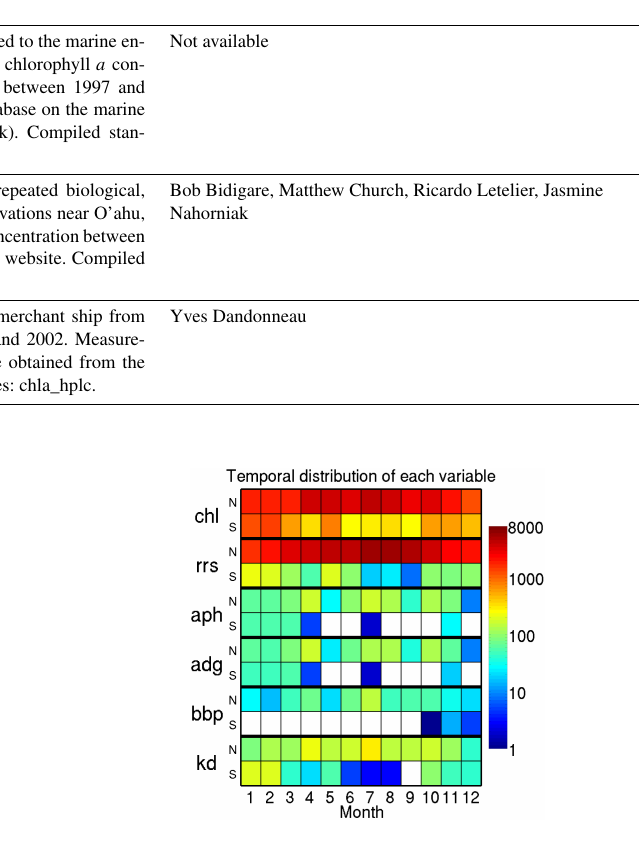
Figure 3. Temporal distribution of chlorophyll a concentration (chl), remote-sensing reflectance (rrs), algal pigment absorption co- efficient (aph), detrital plus CDOM absorption coefficient (adg), particle backscattering coefficient (bbp) and the diffuse attenua- tion coefficient for downward irradiance (kd) in the final table. All chlorophyll data were considered, but for a given station HPLC data were selected if available. Colours indicate the number of stations available for each variable, as a function of months and the hemi- spheres of data acquisition (N – Northern Hemisphere; S – Southern